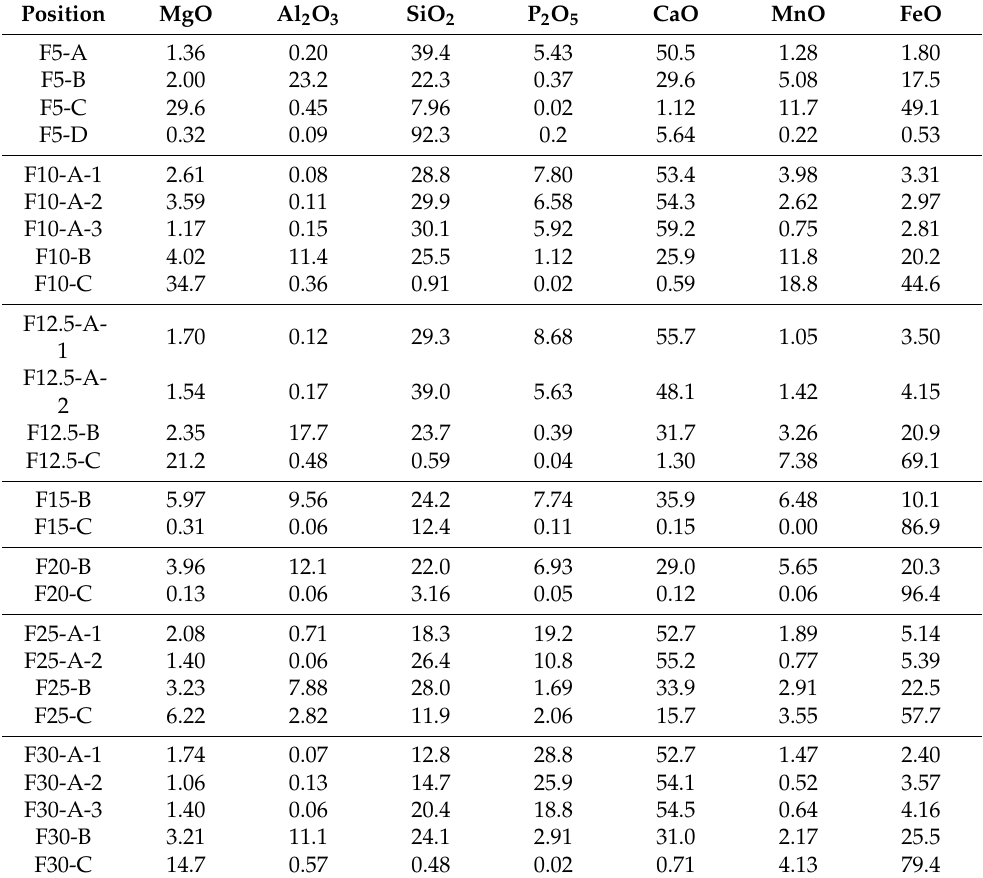
Figure 8. SEM images with the magnification of 1000 times for the Fe 2 O 3 addition amount of 5, 10, 12.5, 15, 25 and 30 g. Table 4. The compositions of each phase in the slag were analyzed by EDS (mass%). Position